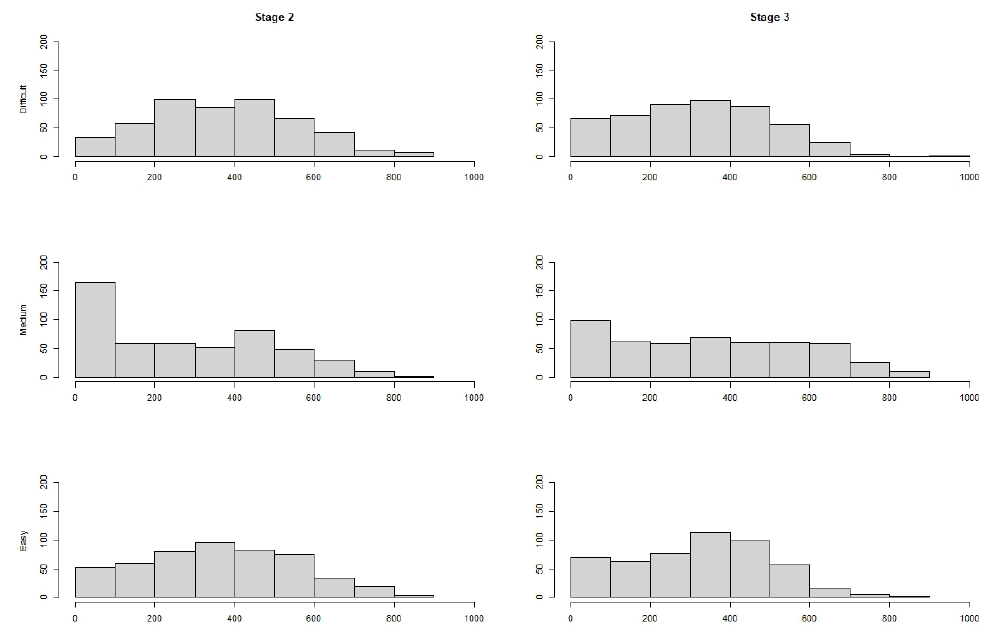
Figure 2. Overall frequency distributions of responses across all 500 iterations to the individual modules with items of three difficulty levels in stages two and three for a condition with 1000 respondents and 63 items. There were no DIF or impact effects, and the WL estimator was used for person parameter estimation.